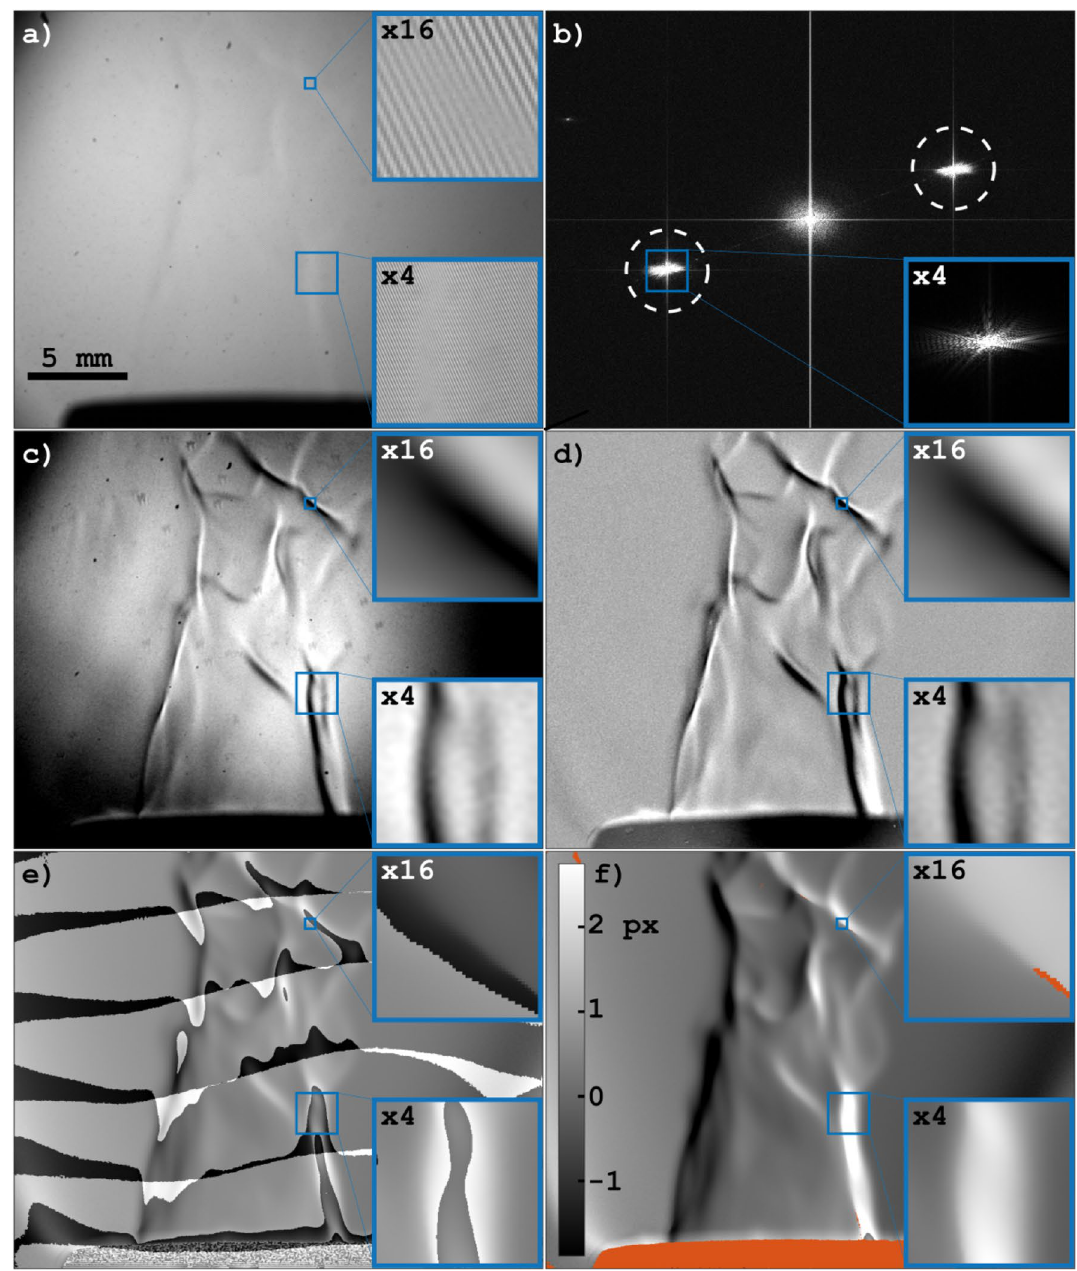
Figure 1. Illustration of the phase analysis process. ( a ) The image of the spatially modulated light pulse guided through a flame. The outlines of the flame are barely discernible, but leave a faint imprint in the modulated structure in the shape of a phase displacement. ( b ) The absolute value Fourier transform of the original image. The encircled Fourier clusters contain the information used to reconstruct the complex flame signal, carried by the light pulse. The size of the low-pass filter used for reconstruction is indicated by the circles. ( c ) The amplitude of the reconstructed signal. ( d ) The amplitude of the signal minus the amplitude of a blank recording. ( e ) The phase shift of the signal, i.e. the difference in phase between the signal and a blank recording. ( f ) The unwrapped phase shift of the signal. The grayscale bar gives the phase shift as displacement in pixels. The orange parts are areas where the amplitude of the signal was too low for proper determination of the phase. The zoomed in sections in ( a ) and ( c )–( f ) are of identical position. See also Supplementary video 1 for a comparison between pure trans-illumination imaging and schlieren based on modulated